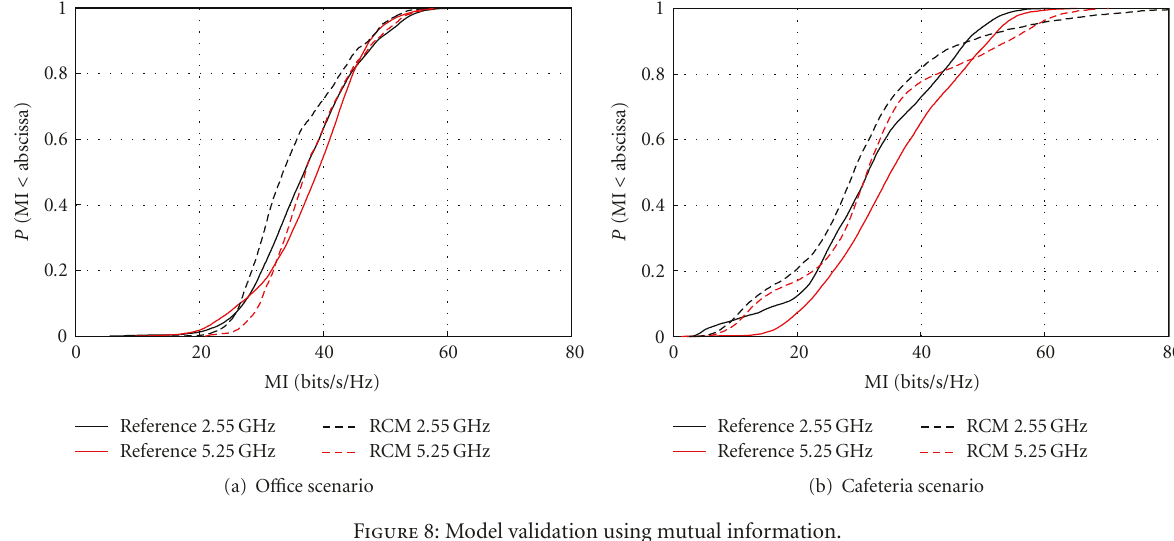
Figure 8: Model validation using mutual information.